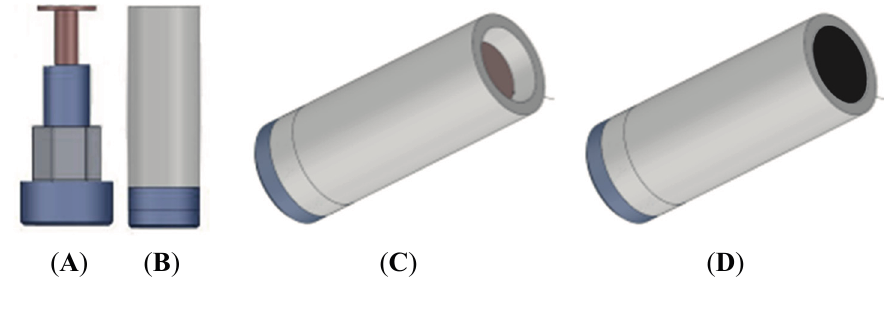
Figure 1. Graphite-epoxy composite electrodes construction scheme. ( A ) Copper disk soldered to the electrical connector; ( B ) Electrical section assembled into the PVC tube; ( C ) Body sensor ready to be filled with the composite paste; ( D ) Final appearance after hardening and